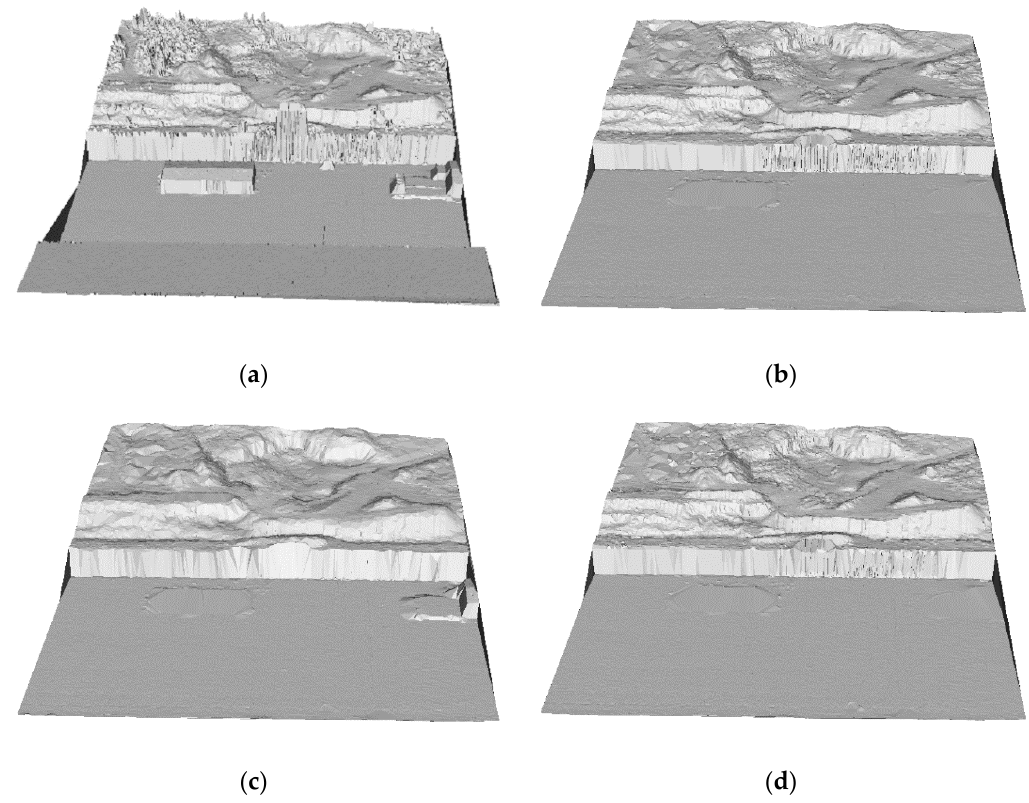
Figure 12. Comparison of the proposed method and TerraScan on the details of the complex area: ( a ) raw ALS data; ( b ) ground truth; ( c ) result of TerraScan; and ( d ) result of deep CNN model.